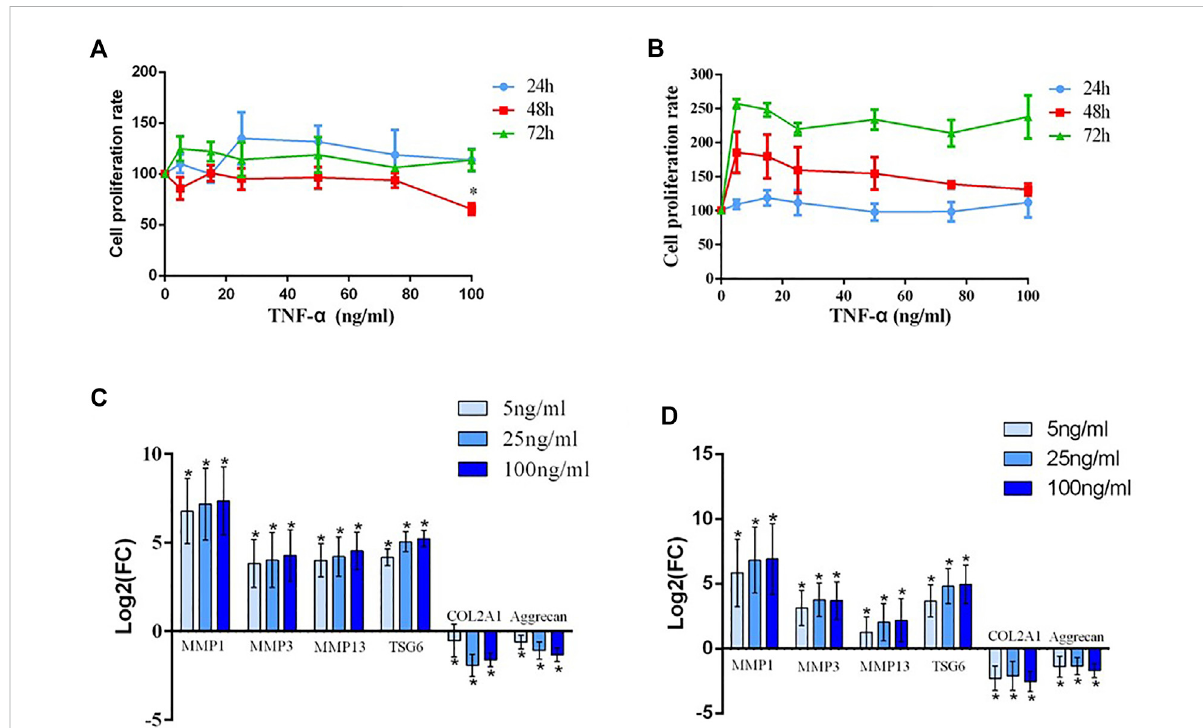
FIGURE 2 (A) The detection of the human chondrocyte proliferation rate after treatment with different concentrations (20, 40, 60, 80, and 100 ng/ml) of TNF- α andwithoutserumfor24 h,48 h,and72 h;*indicates p < 0.05. (B) Thedetectionofthehumanchondrocyteproliferationrateaftertreatment with different concentrations (20, 40, 60, 80, and 100 ng/ml) of TNF- α and with serum for 24 h, 48 h, and 72 h. (C) The mRNA expression of MMP1, MMP3, MMP13, TSG-6, COL2A1, and aggrecan after chondrocytes from patients with KBD were interfered with TNF- α ; * indicates p < 0.05. (D)